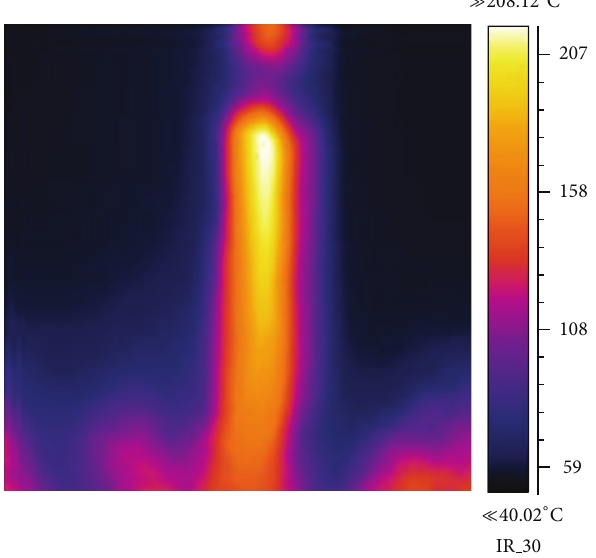
Table 2: Goodness of fit parameters for Figures